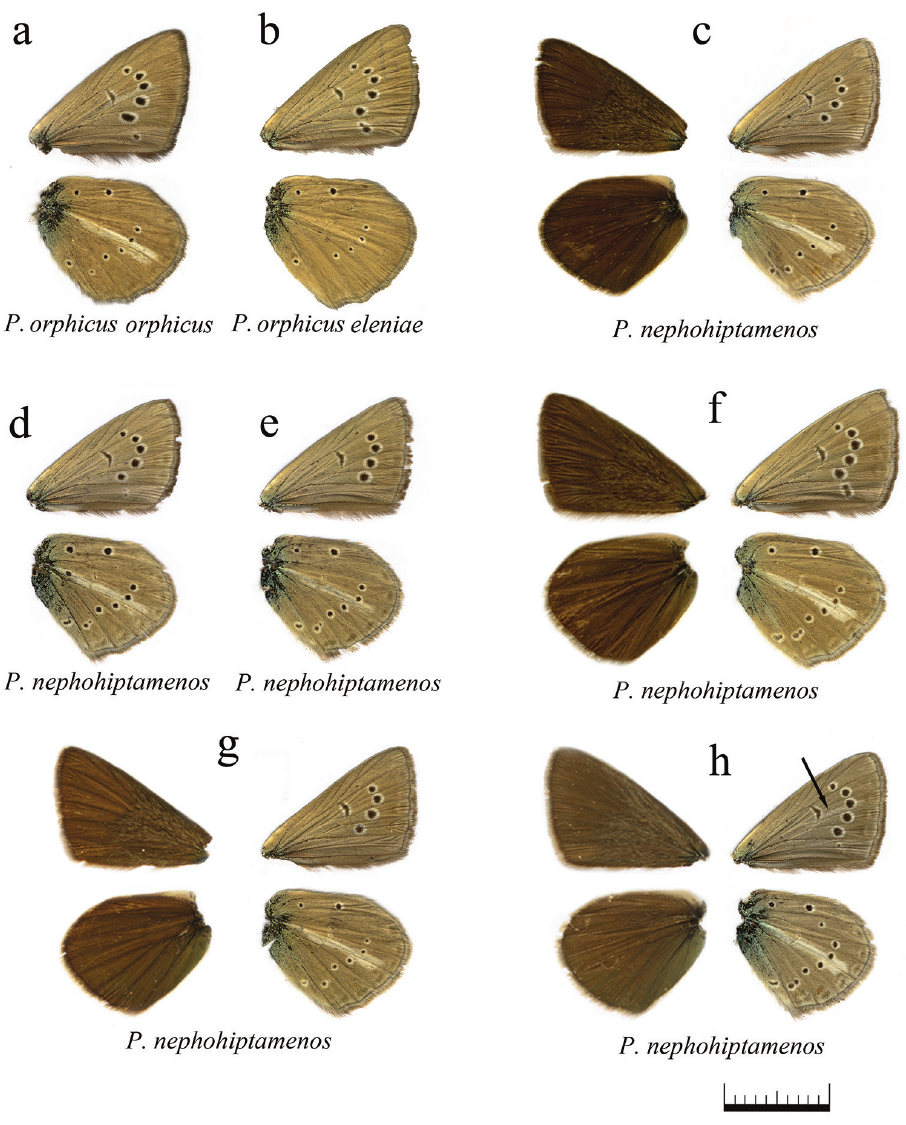
Figure 14. The coloration and wing pattern of P. orphicus orphicus , P. orphicus eleniae and P. nephohipta- menos . The letters correspond to the following sample numbers: a LR-08-D561 b LR-08-431 c LR-08- 483 upperside and underside d LR-08-496 e LR-08-498 f LR-08-499 upperside and underside g LR- 08-485 upperside and underside h LR-08-494 upperside and underside, white postdiscal streak between discal spot and submarginal marking on the forewing underside is shown by arrow. Bar = 10